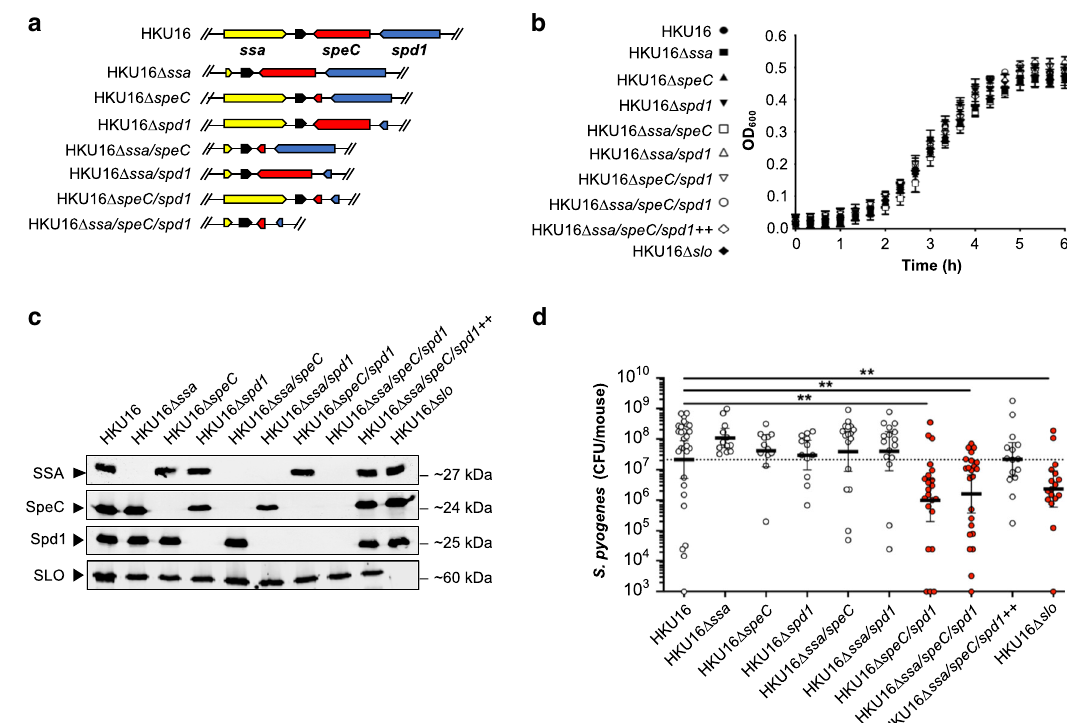
Fig. 4 Φ HKU.vir-encoded exotoxins and SLO are critical for HKU16 nasopharyngeal infection. a Illustration of the genetic in-frame deletions of Φ HKU. vir-encoded exotoxins in HKU16 as described in Materials and Methods. b Growth curves of indicated HKU16 strains in CDM from three independent experiments. Data are presented as mean values± SD. c Immunoblot detection of SSA, SpeC, Spd1, and SLO expression from indicated HKU16 strains. The molecular mass of each protein (kDa) is indicated to the right. d Individual “ humanized ” B6 mice that express HLA-DR4, HLA-DQ8 and CD4 were nasally inoculated with ∼ 1 × 10 8 bacterial colony forming units (CFU) with indicated HKU16 strains and nasopharyngeal CFUs were assessed at 48 h post infection. Each symbol represents CFUs from an individual mouse ( n ≥ 12). Presented is the geometric mean with 95% con fi dence interval. Signi fi cance was assessed using the Kruskal – Wallis test with the Dunn ’ s multiple comparisons post-hoc test against the HKU16 control group (** p = 0.0012 for HKU16 Δ speC/spd 1, ** p = 0.0041 for HKU16 Δ ssa / speC / spd 1, and ** p = 0.01 for HKU16 Δ slo ). Source data are provided as a Source Data fi le.